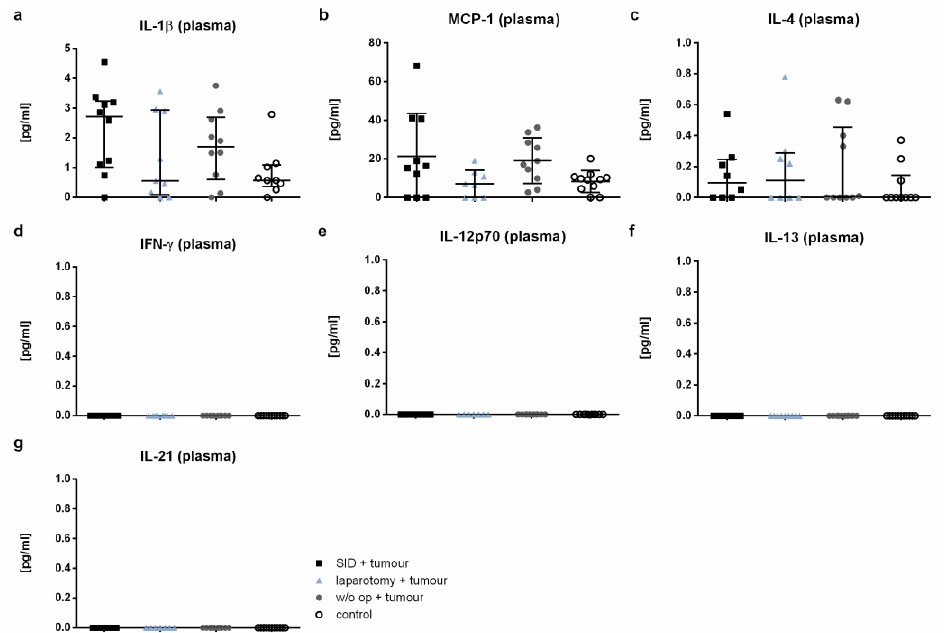
Figure A1. Spleen cell populations. The spleen cell populations were determined by flow cytome- try. The graphics either show the absolute cell numbers or the percentage of vital spleen cells. ( a ) The absolute cell numbers of the B-, T- and NK-cells. ( b ) The relative spleen cell numbers in tumour- free animals. Values in ( a , c , e , f ) represent the median with interquartile ranges; values in ( b , d , g ) the mean and standard error with n = 9 – 15 animals per group (SID + tumour: n = 11; laparotomy + tumour: 9; w/o op + tumour: 11; SID: 11; laparotomy: 15; control: 15); ** p < 0.01.